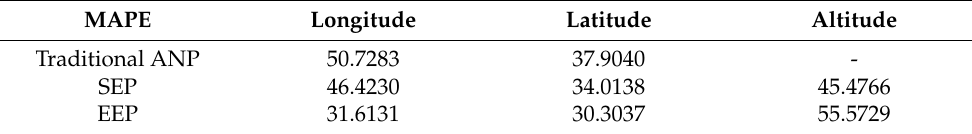
Table 5. Comparison of actual navigation performance evaluation algorithm